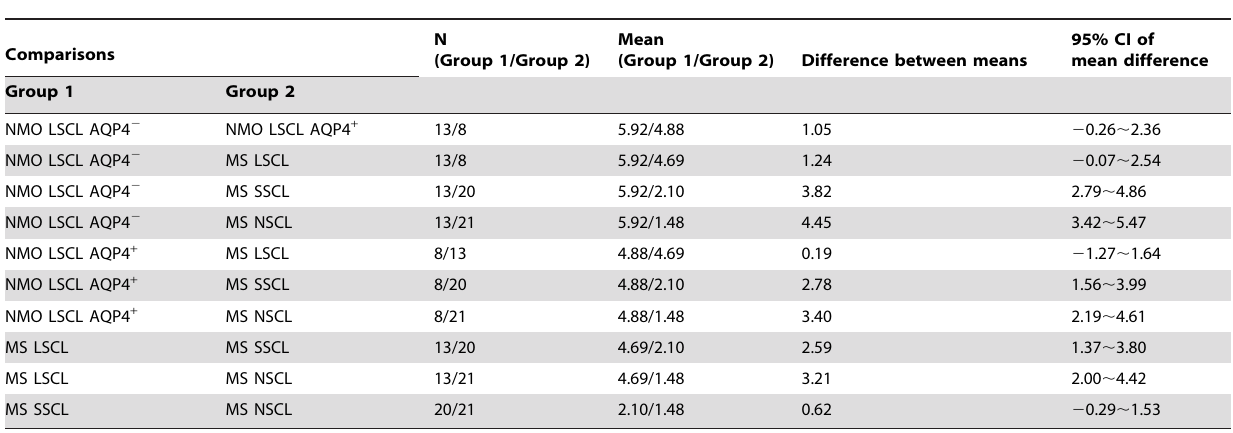
Table 4. Comparisons of the mean of EDSSp post-interferon- b therapy between groups.